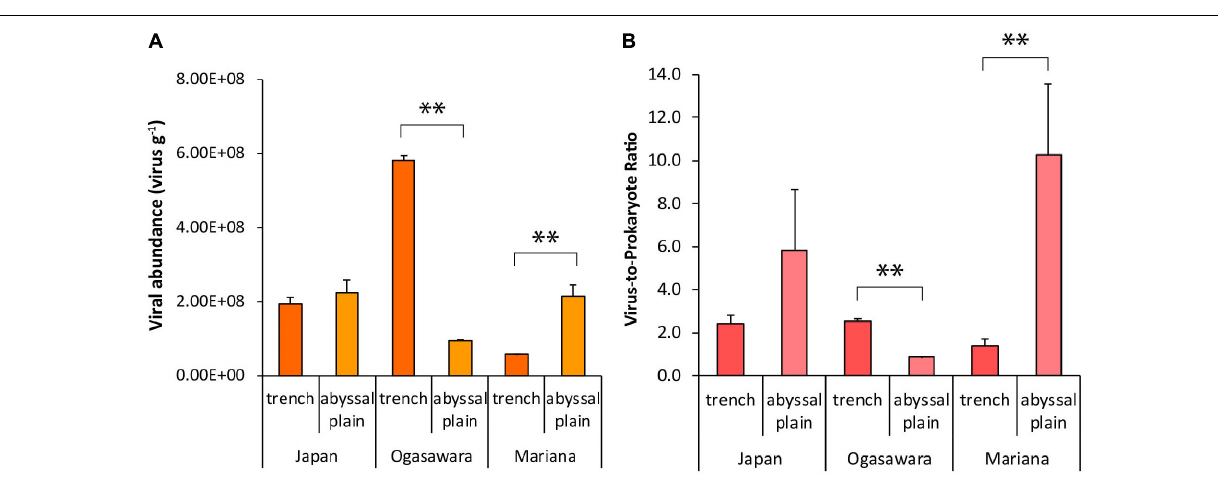
Frontiers in Microbiology |